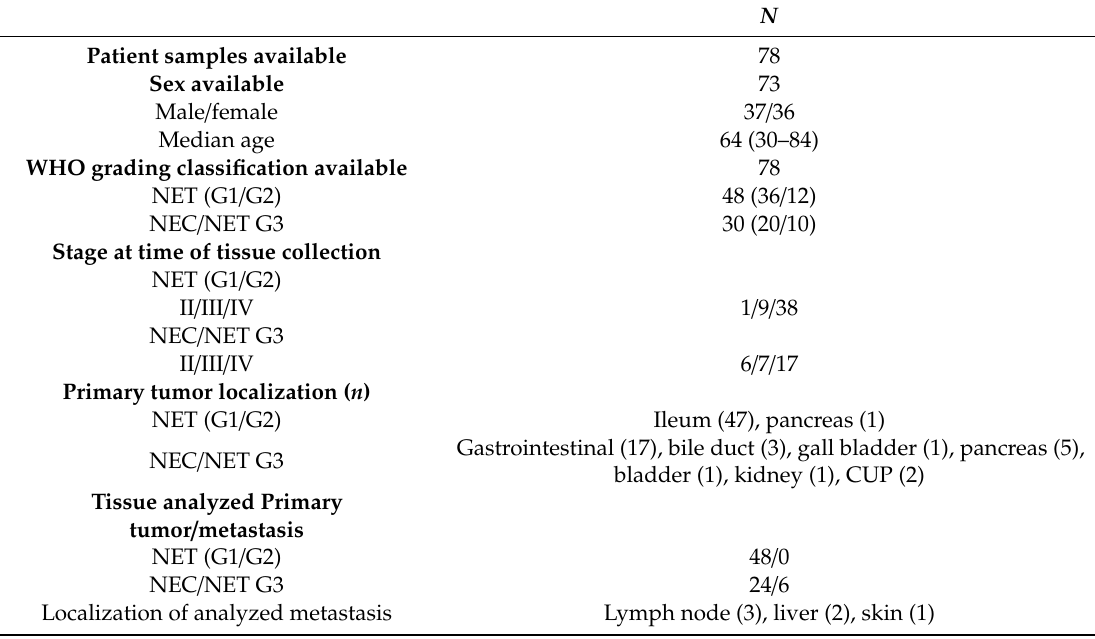
Table 1. Patient characteristics for samples used for immunohistochemistry and mRNA profiling.